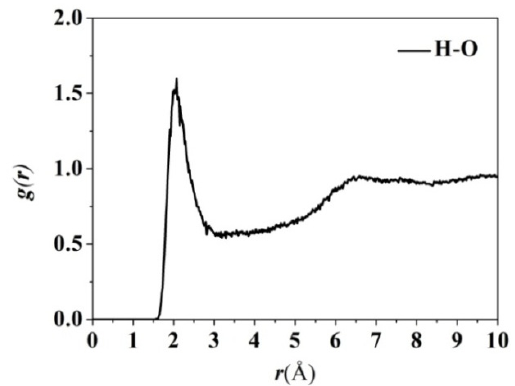
Figure 11. Radial distribution function ( g H-O ( r )) of H (in amide group) and O (in amide group and imide ring) in